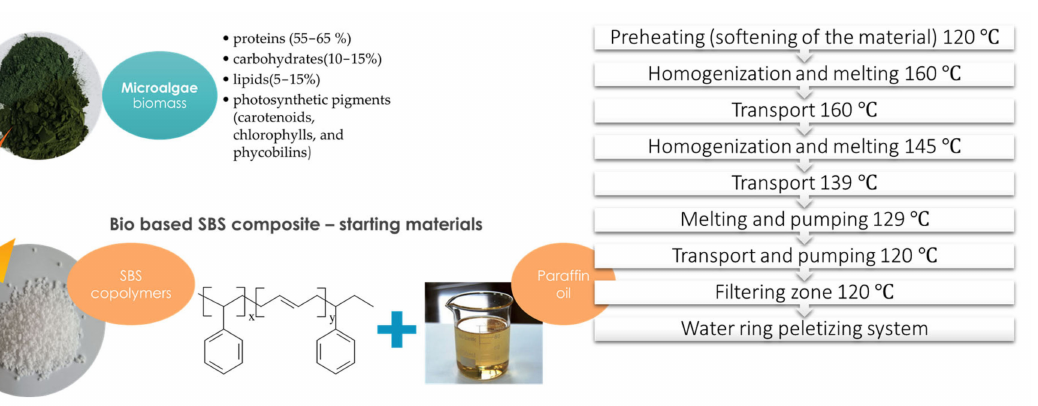
Figure 1. Preparation procedure of MSBS composite